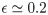
An example of long–range positive epistasis with ϵ≃0.2.Individual mutations E6 (red) → G6 (green) and A23 (green) → E23 (red) are neutral and deleterious, with ΔP1≃0 and ΔP2≃−0.24 respectively (ΔP12≃−0.04). E6 and A23 are ordered in the initial ensemble, while E23 is ordered and G6 is disordered in the double mutant ensemble. In the double mutant, material is transferred from ordered to disordered phase regions of the ensembles by the mutation E6 → G6, while the mutation A23 → E23 enhances the stability of the nuclear scaffolding. The distance between mutated positions in panel (A) is R≃8 Angstroms. Folded ensembles for the initial and mutated sequences are shown in S6 Fig.